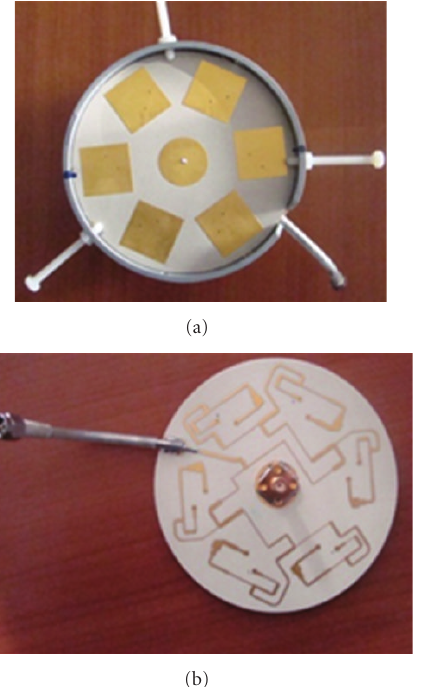
Figure 14: Top and back views of the manufactured prototype with the feed distribution network.